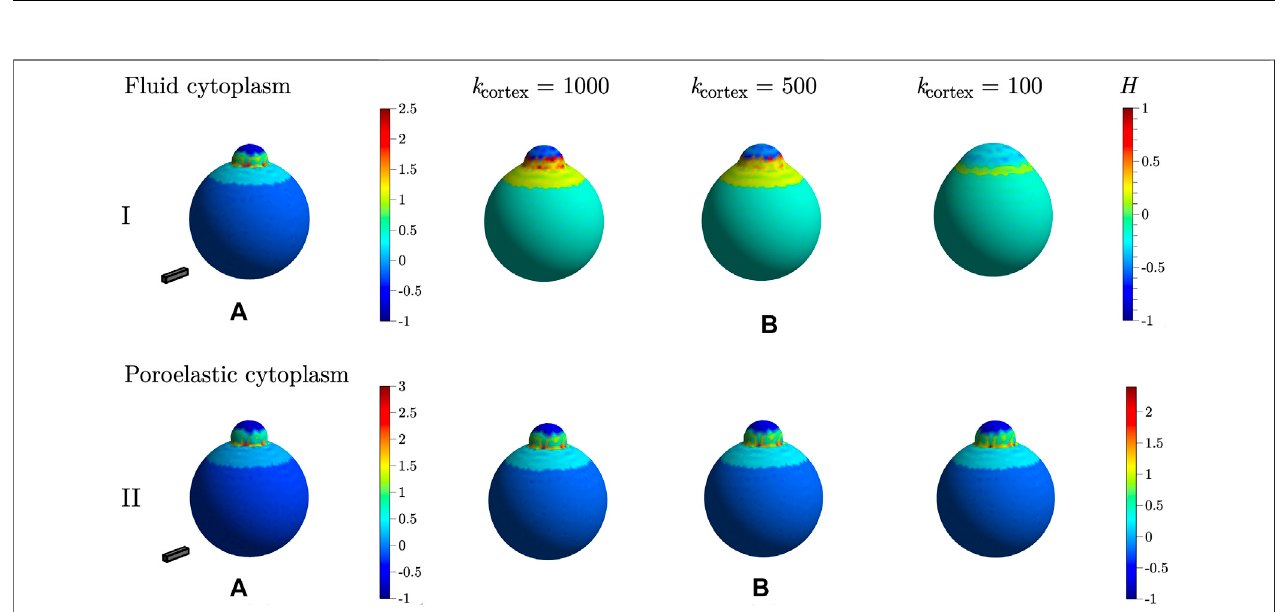
FIGURE 5 | Bleb height (A) , relative bleb volume (B) , and maximum pressure inside the cell (C) over time for a simulation using a fl uid cytoplasm (solid lines) and poroelastic cytoplasm (dashed lines). The open circle, fi lled circle, and × denote the time value when bleb height, relative bleb volume, and maximum pressure, respectively, achieve 90% of their steady state values.